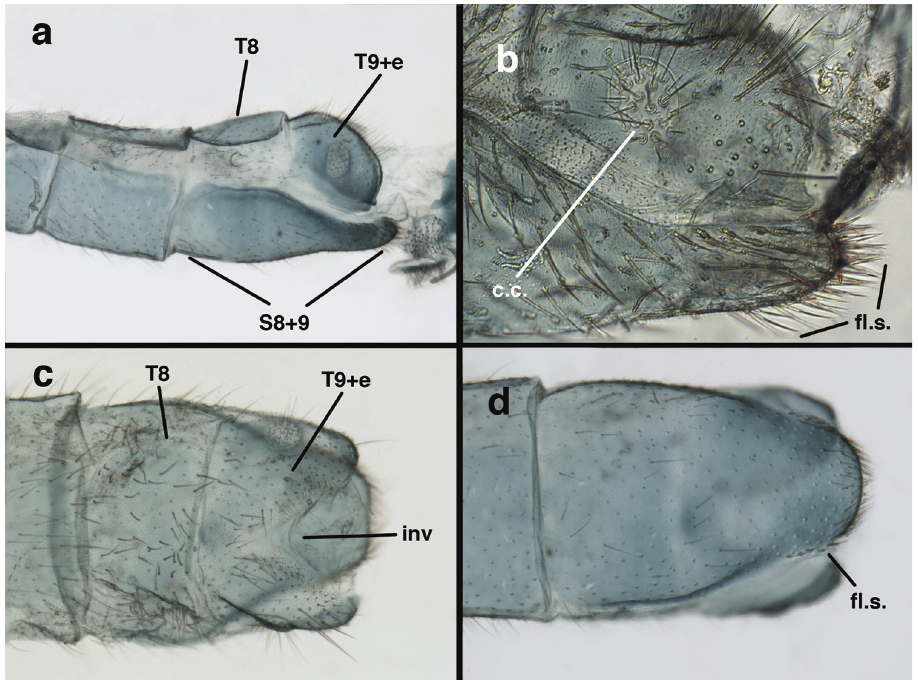
Figure 128. Ungla confraterna (Banks): Male abdomen, ( a ) segments A7-terminus, lateral ( b ) tip of terminus, lateral, showing callus cerci and flanged setae on distolateral upper margins of S9 ( c ) T8, T9+ectoproct, dorsal ( d ) fused sternite 8+9, ventral, with large, flanged setae on distolateral margin of S9. c.c. callus cerci fl.s. flanged setae inv invagination of dorsal T9+ectoproct S8+9 fused eighth and ninth sternites T8 eighth tergite T9+e fused ninth tergite + ectoproct (Argentina; a, d Mendoza, USNM; b, c Salta,